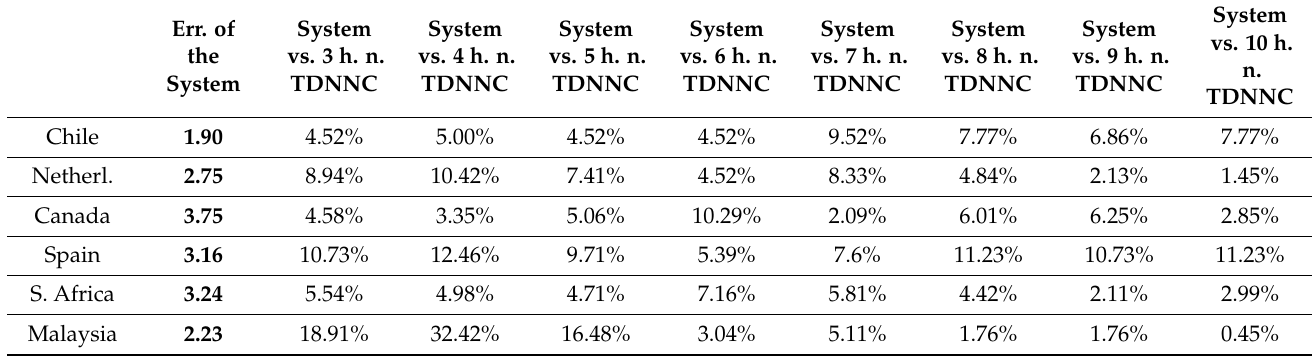
Table 2. Averaged relative error of the entire forecasting system in [%] with the relative accuracy increases achieved using the optimal TDNNC based forecasting methodology in comparison with the individual TDNNCs.